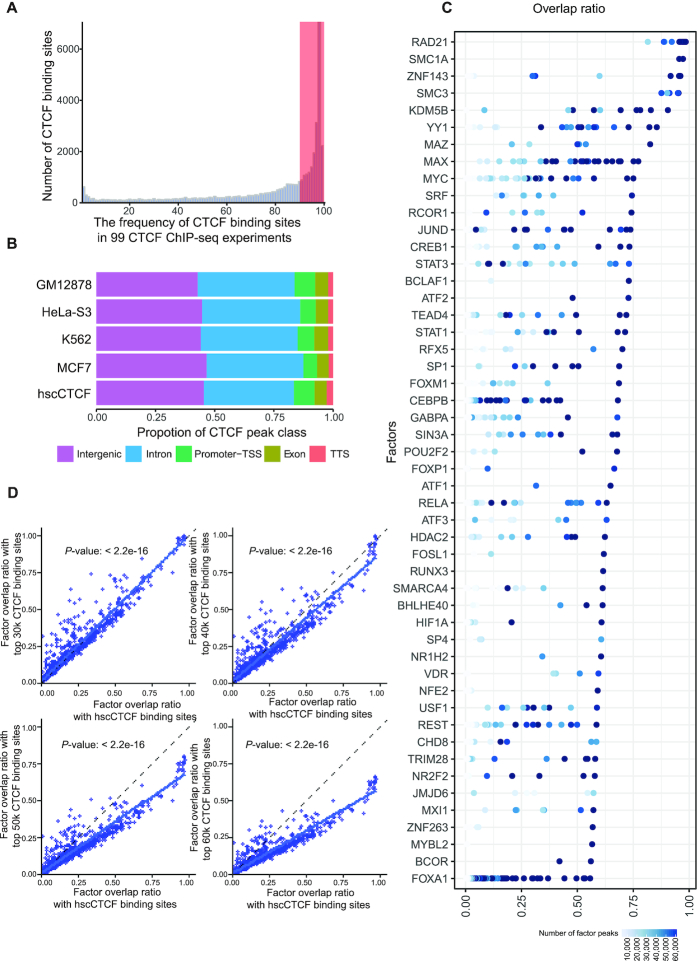
Identification of human super conserved CTCF (hscCTCF) binding sites. (A) Bar plot showing the distribution of conserved CTCF binding sites derived from four CTCF ChIA-PET datasets in 99 CTCF ChIP-seq datasets. (B) The genomic distribution of hscCTCF binding sites and genome-wide CTCF binding sites for the indicated cell lines. Genomic features are color-coded in the legend bar. The x-axis shows the cumulative percentage of genomic occupancy of each feature. (C) The top 50 protein factors ranked by each factor's maximum overlap ratio with hscCTCF sites. The overlap ratio for each factor with hscCTCF was calculated by using the overlapped hscCTCF binding sites divided by total hscCTCF binding sites. Each dot represents a ChIP dataset. (D) Scatter plots showing the relationship between the factor overlap ratio generated using hscCTCF binding sites and the ratio generated using the top 30 000, 40 000, 50 000 and 60 000 CTCF binding sites.